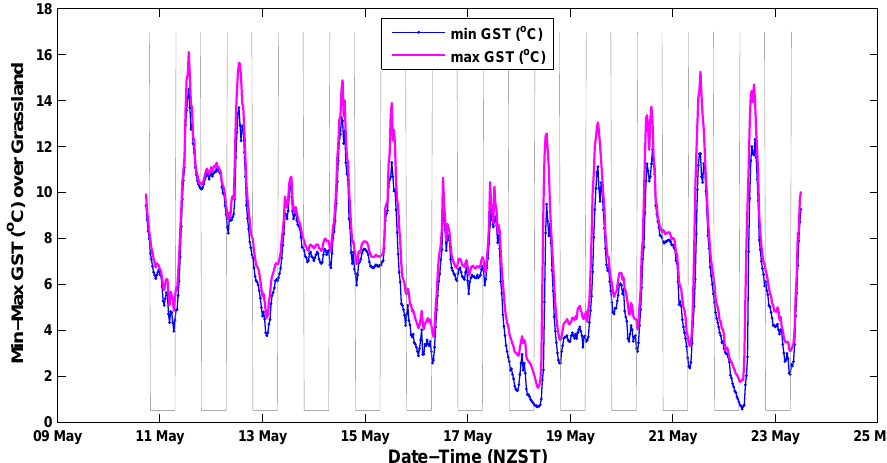
Figure 2. Minimum and maximum ground temperature measurements from 5 iButtons over Grassland LC type (30-min rate, May 2011). Night observations (7 pm–7 am) are distinguished by the grey-line overlaid on the